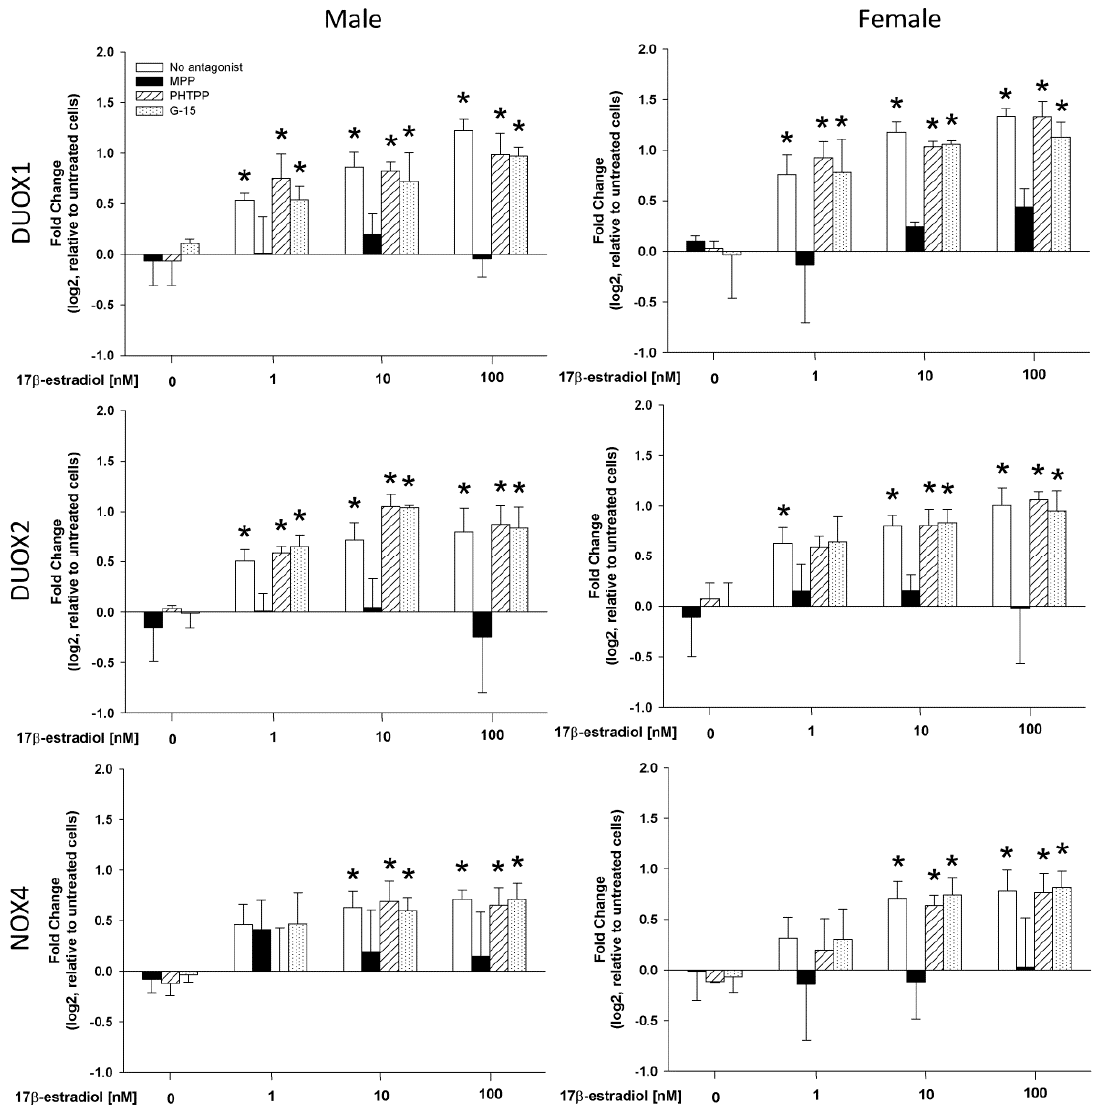
Figure 3. The mRNA expression (log2 fold change) of NOX/DUOX oxidases in cells derived from male and female rat thyroid. Cells were incubated in the presence of 17 β -estradiol (0.0 nM, 1.0 nM, 10 nM or 100 nM) alone or with addition of one of the 17 β -estradiol receptor antagonists (10 µ M). mRNA expression was determined by real-time PCR and was expressed relative to the untreated cells. Bars represent the mean ± SE of three independent experiments. * p < 0.05 vs. respective Control antagonist (without 17 β -estradiol).